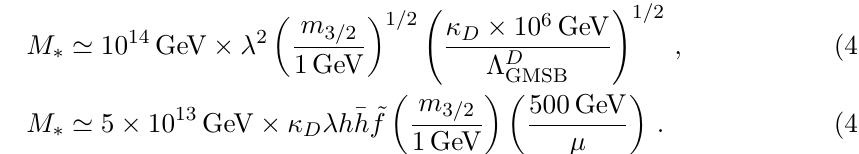
. u,d and the Higgs boson mass µ becomes too large (see eq. (A.9)). Z D